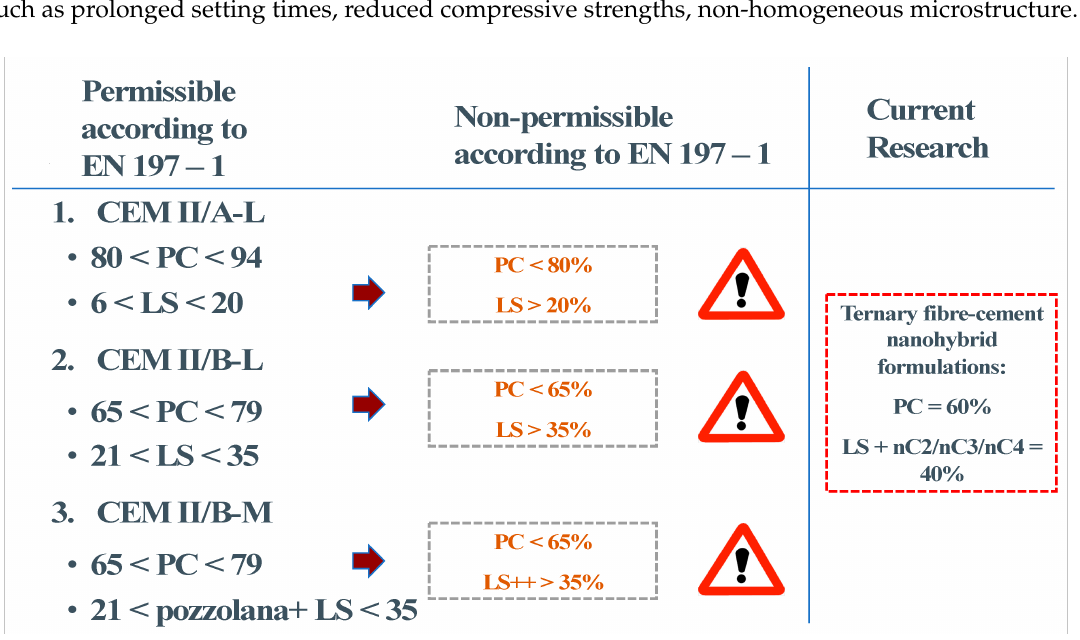
Figure 1. Permissible and non-permissible limits of clinker substitution / SCM (Supplementary Cementitious Materials) addition according to EN197-1 and challenge of current research. (PC stands for Portland cement and LS for